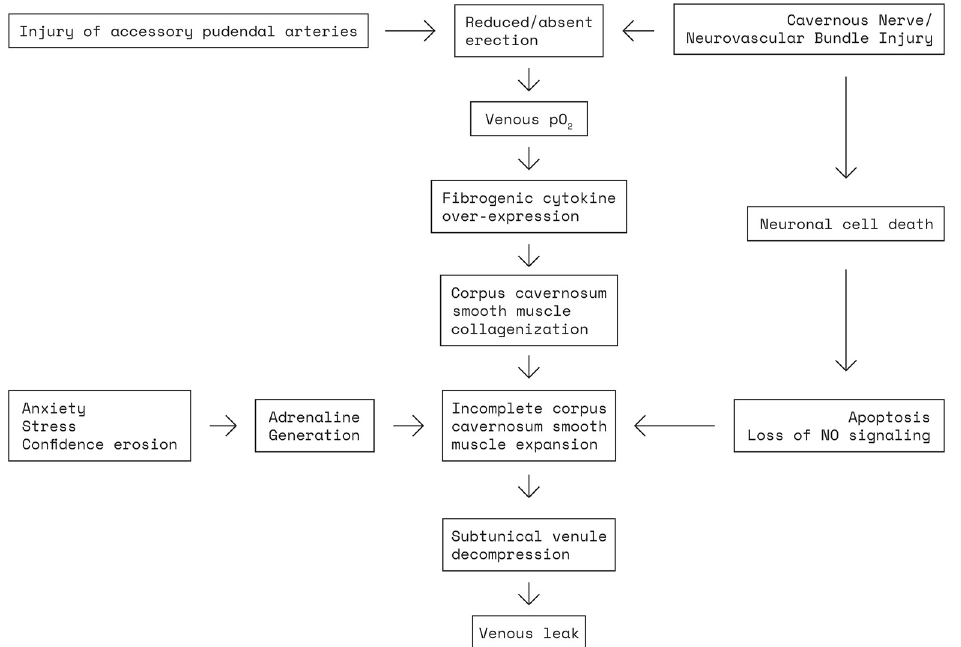
Figure 4. Pathophysiology of post radical prostatectomy erectile dysfunction. pO 2 = partial pressure of oxygen; adapted from Mulhall et al.